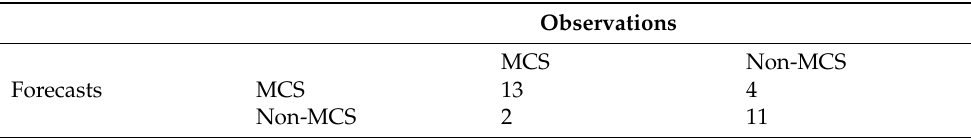
Table 3. Contingency table elements for observed and forecasted MCS and non-MCS events.